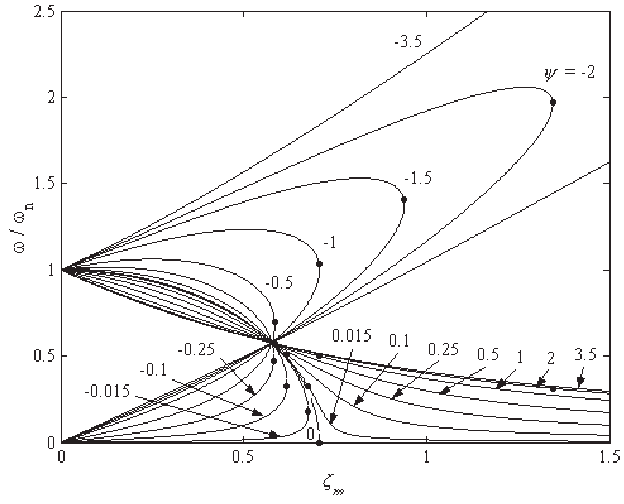
Fig. 14. Local maximum and minimum shift with respect to ω/ω n for some ψ